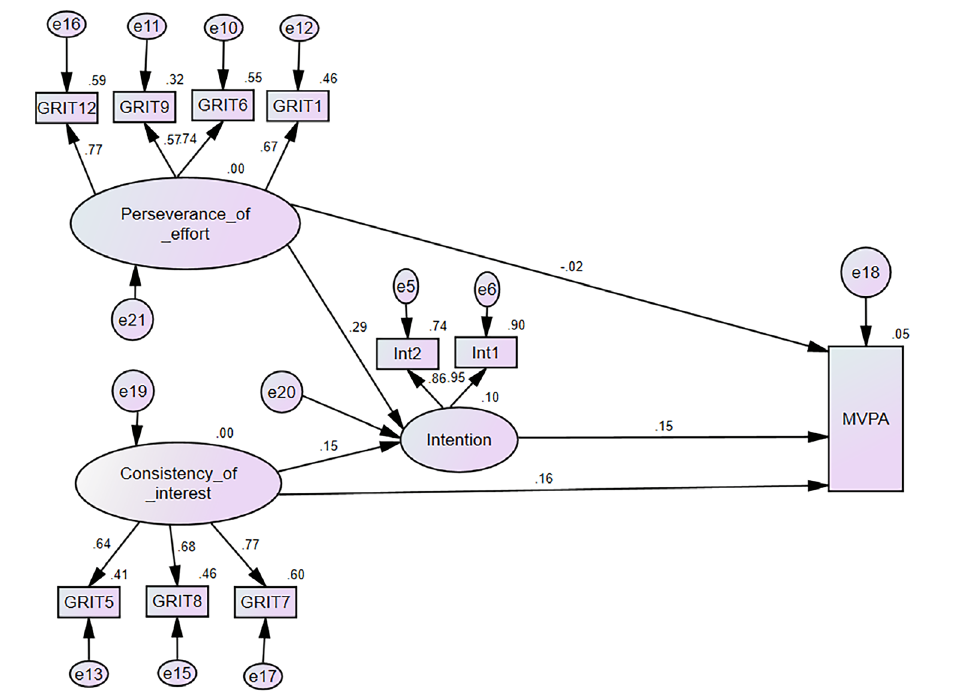
FIGURE 1 Structural model predicting moderate-to-vigorous physical activity regarding the dimensions of grit and intention. Abbreviations in boxes are measured variables; e10, e12, e11, e16, e13, e15, e17, and e18 are error terms associated with each measured variable. MVPA = moderate-to-vigorous physical activity.